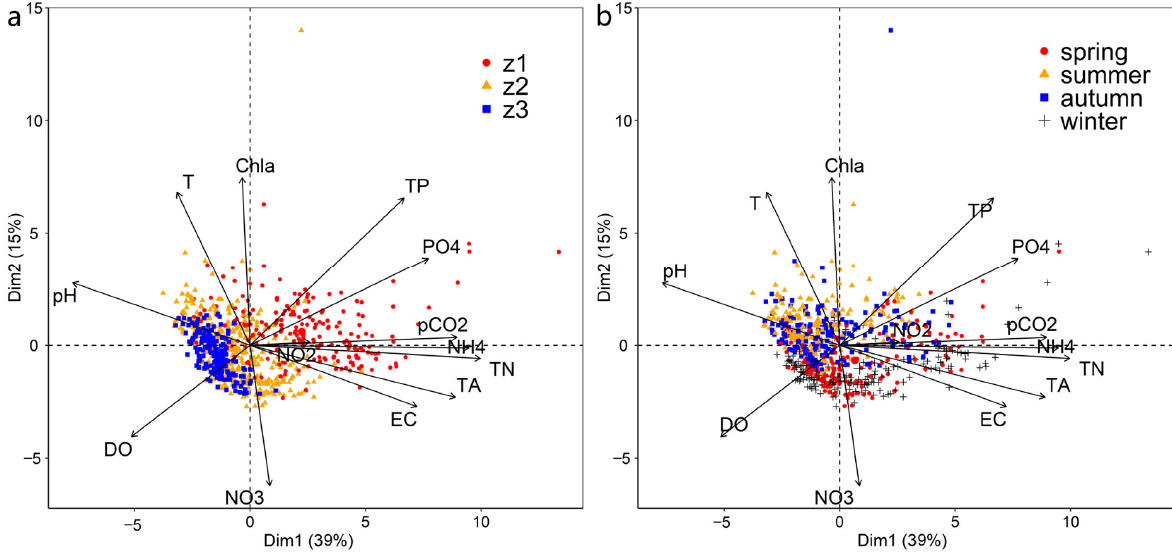
Figure 6. Principal component analysis (PCA) of pCO 2 and key water variables: ( a ) spatial patterns; ( b ) seasonal patterns.